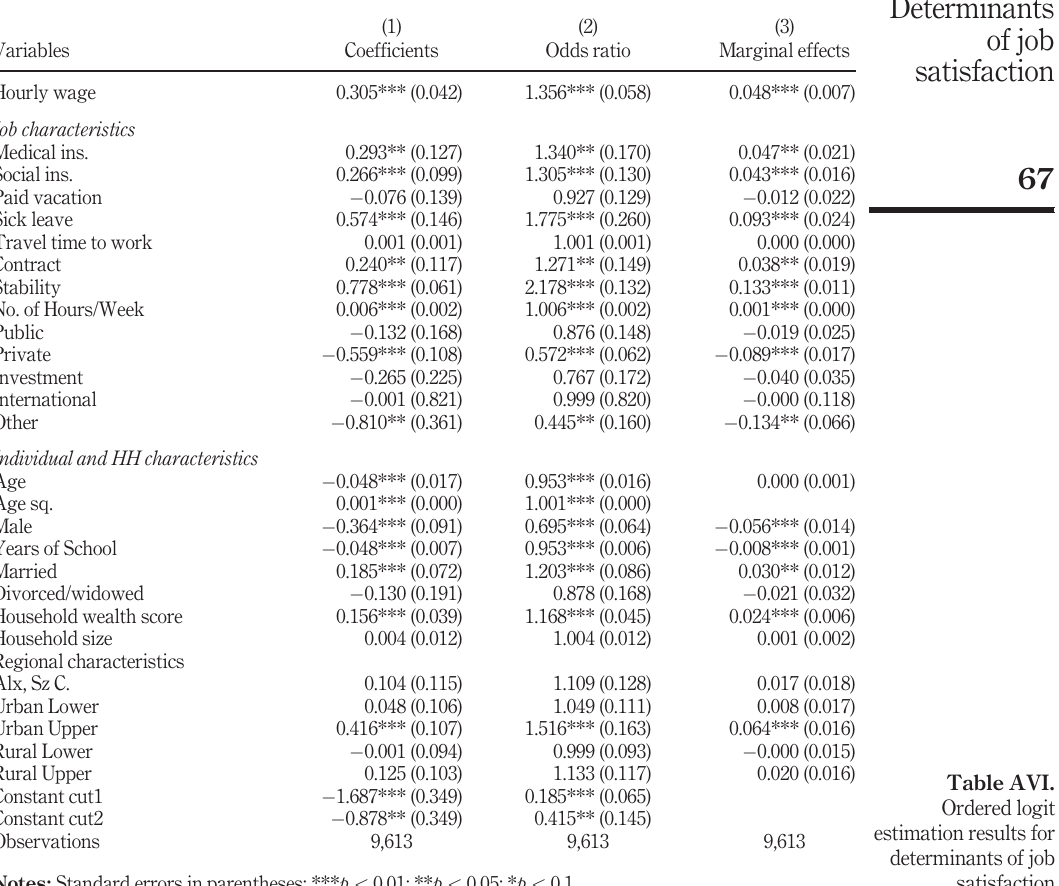
Table AVI. Ordered